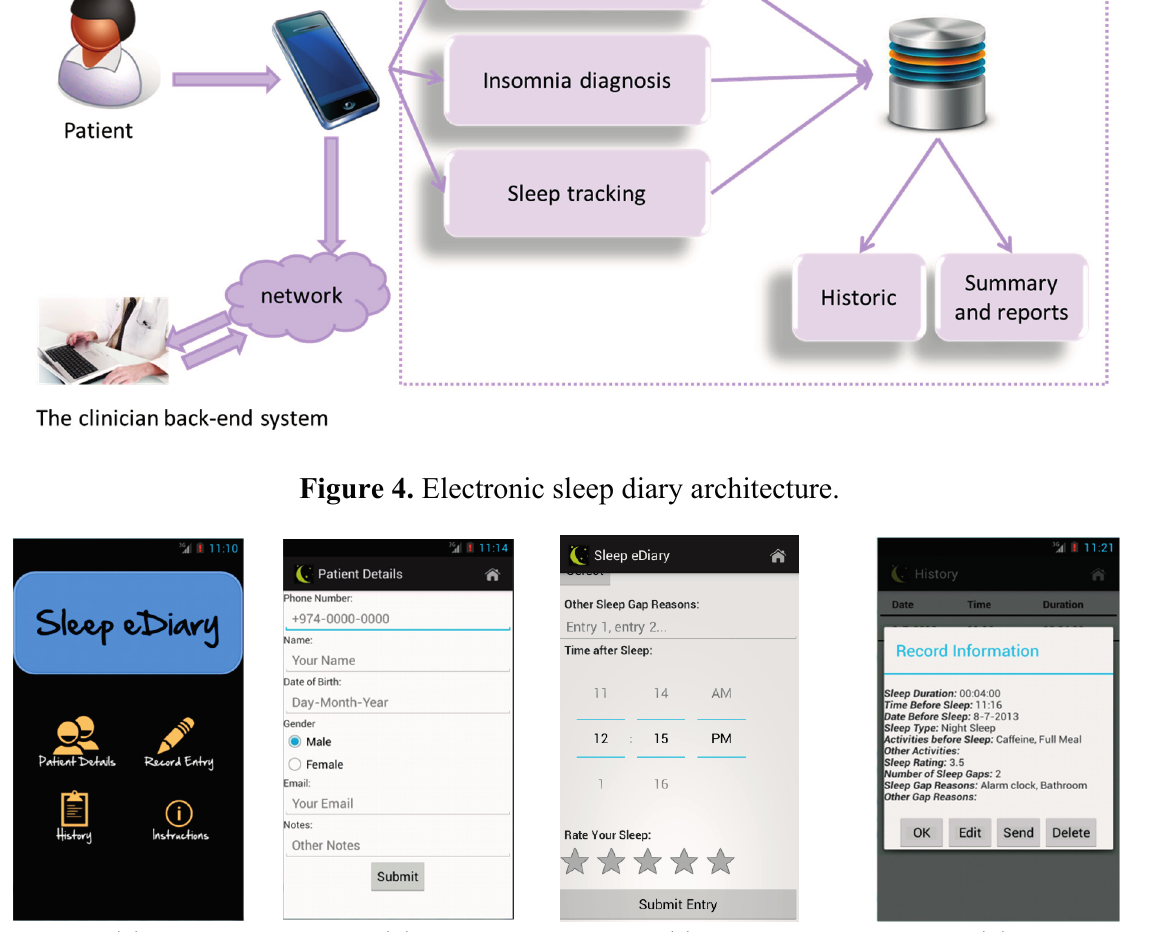
Figure 5. Our OS-Android based sleep diary “ Sleep eDiary ”. ( a ) Main menu of the sleep diary; ( b ) Patient’s details; ( c ) Record entry to evaluate the sleep quality; ( d ) The summary sent to the clinic’s